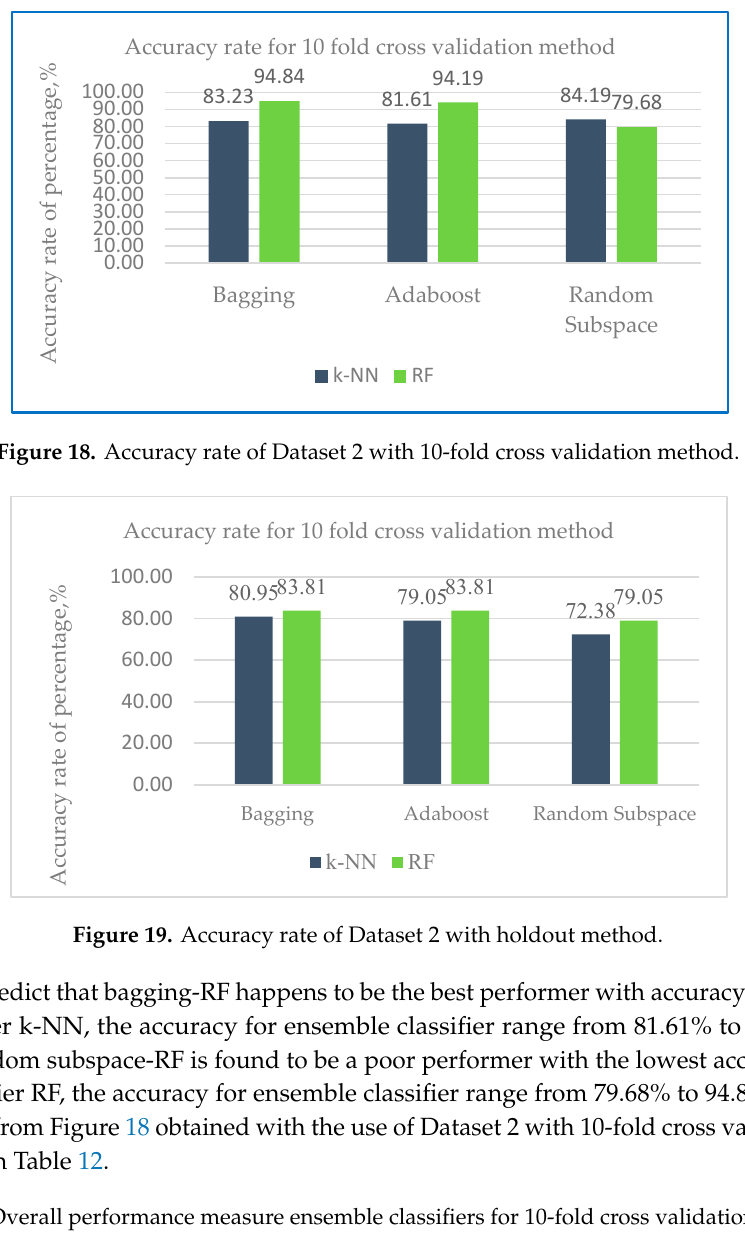
Figure 17. ROC graph activity of ensemble classifier bagging ( a ), Adaboost ( b ), random subspace ( c ) with RF classifier using holdout method Dataset 2.